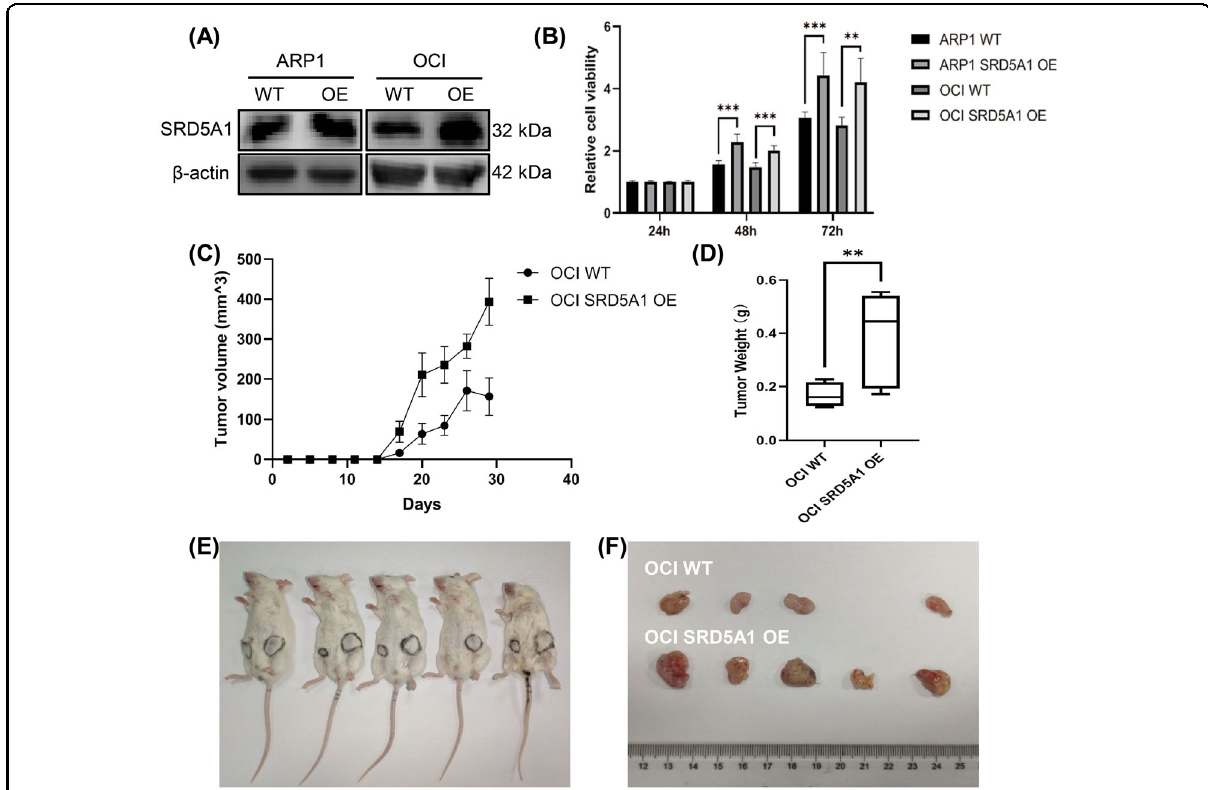
Fig. 3 SRD5A1 overexpression promotes MM cellular proliferation in vitro and in vivo. A Western blotting analysis for SRD5A1 expression of WT and SRD5A1-OE cells. B Histogram plot depicted the growth of WT and OCI-MY5 SRD5A1-OE cells. C The oncogenic effect of SRD5A1 was examined in subcutaneous transplantation mouse models using OCI-MY5 WT and OCI-MY5 SRD5A1-OE cell lines. The result indicated that SRD5A1 signi fi cantly promoted OCI-MY5 tumor growth. D After treatment, the tumor weight of the SRD5A1-OE group was higher than that of the WT group. E , F The NOD-SCID mice injected subcutaneously with OCI-MY5 WT (left) and OCI-MY5 SRD5A1-OE (right) cells were sacri fi ced, and tumors were isolated. * P < 0.05, ** P < 0.01, *** P <